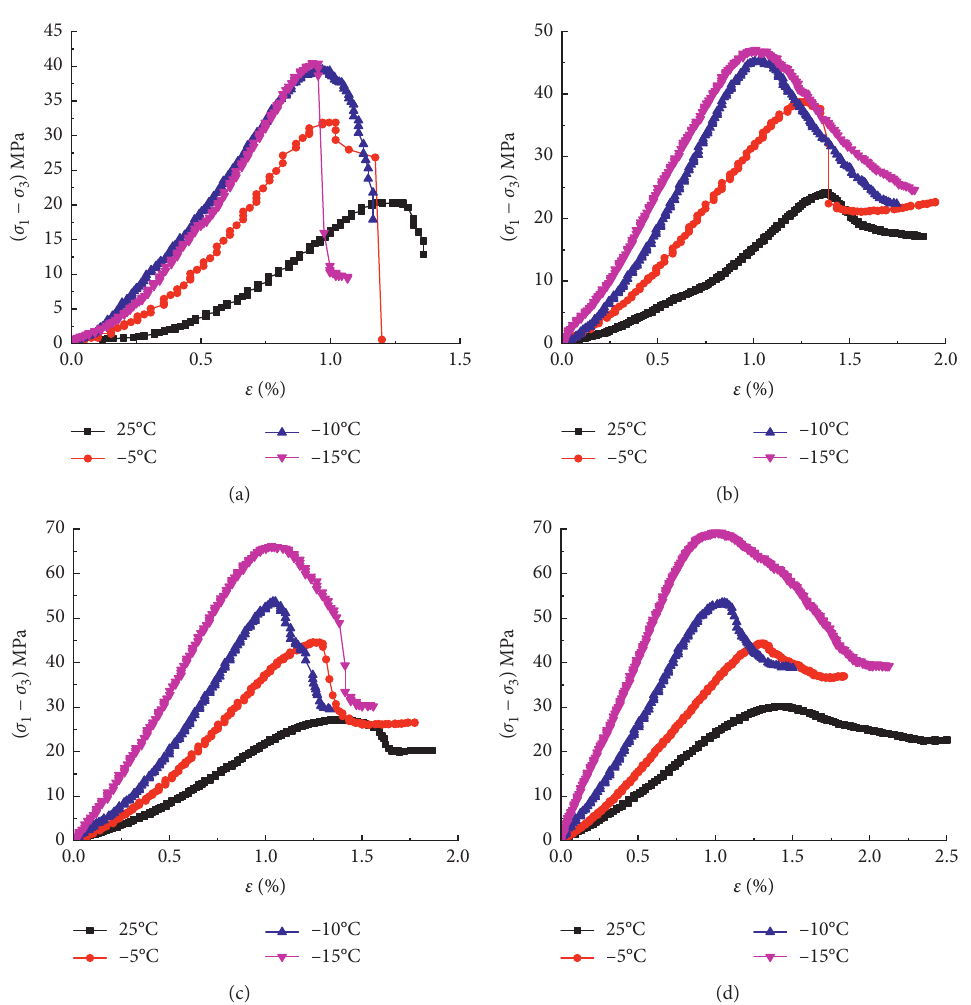
Figure 3: Stress-strain curves with different confining pressures: (a) 0MPa, (b) 4MPa, (c) 6 MPa, and (d)